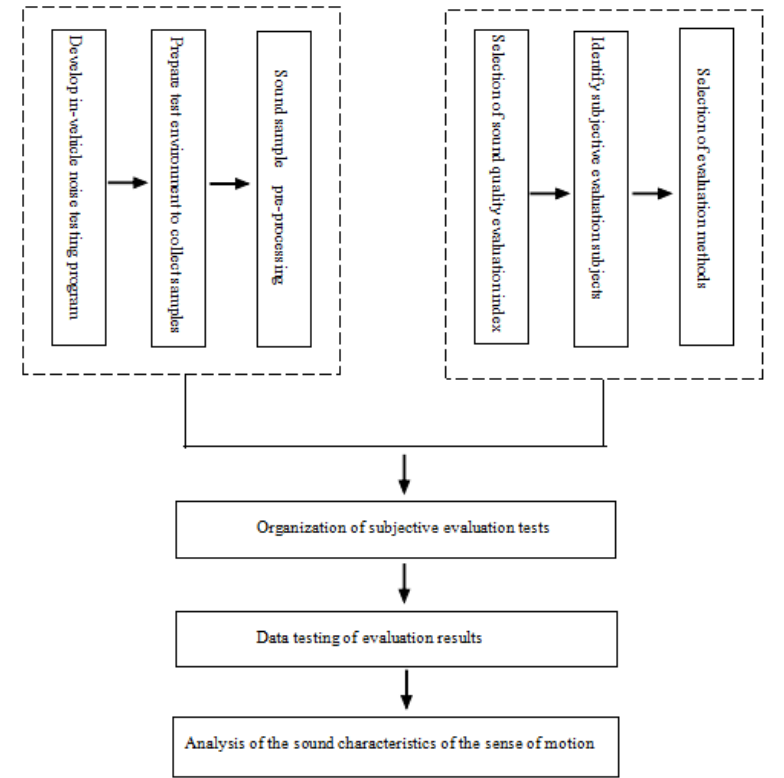
Figure 3. Flowchart of engine sound motion sense analysis.